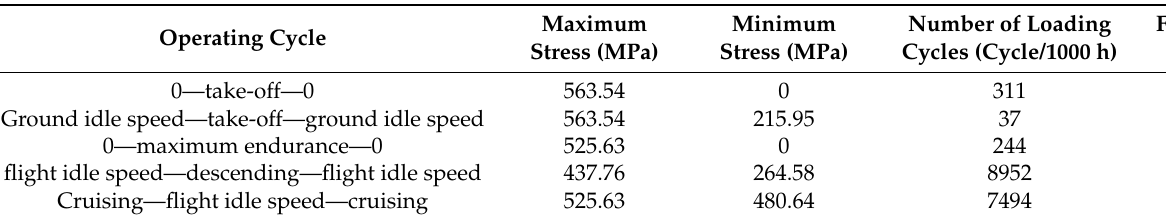
Table 4. The fatigue loading spectrum of the blade in typical engine conditions.